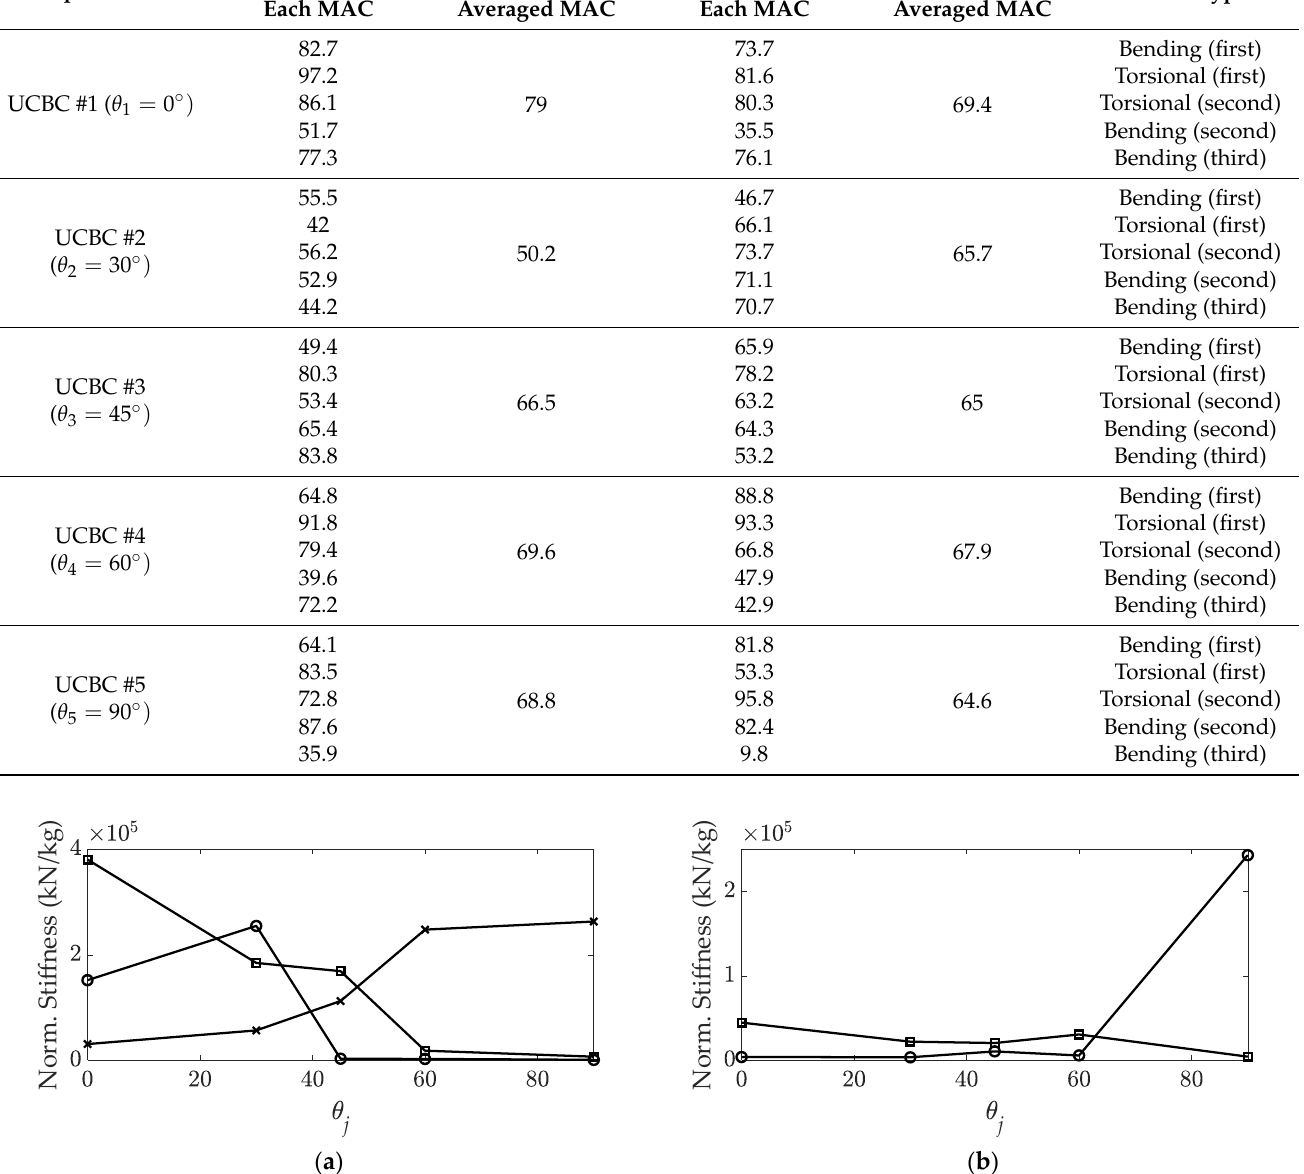
Figure 8. Variations in the structural stiffness considering only MAC values: ( a ) bending modes, : first bending mode; : second bending mode; : third bending mode; ( b ) twisting modes, : first twisting mode; : second twisting mode.